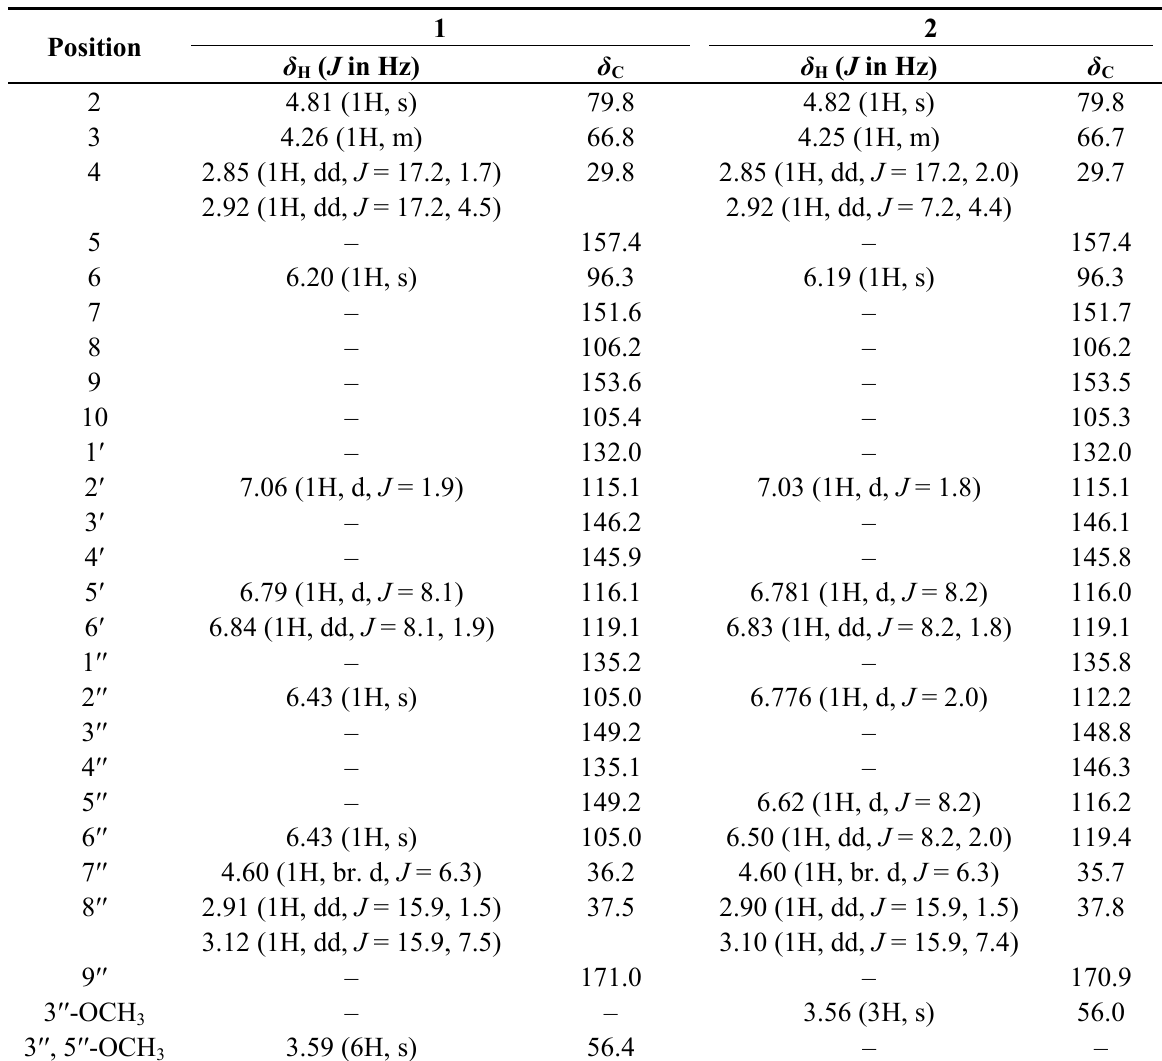
Table 1. 1 H-NMR (600 MHz) and 13 C-NMR (150 MHz) spectra data of compounds 1 and OD, J in Hz, δ in ppm). 2 (in CD 3